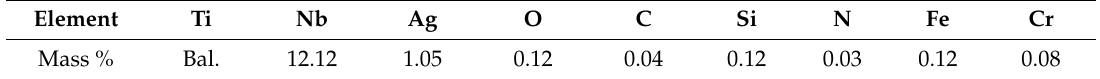
Table 1. Chemical Composition of